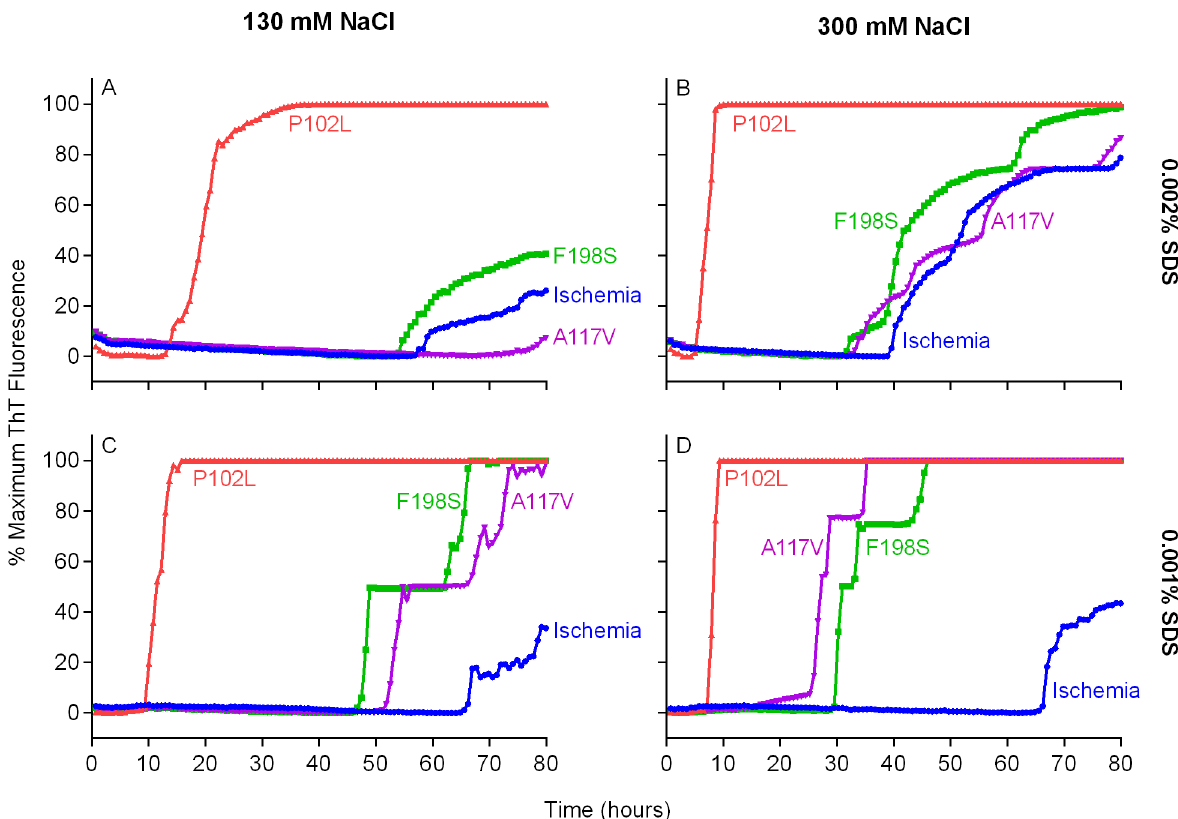
Fig 2. Detection of GSS P102L, F198S and A117V PrP D types by RT-QuIC using BV rPrP Sen , 300mM NaCl and 0.001% SDS. Quadruplicate RT-QuIC reactions were seeded with 10 -4 dilutions of human frontal cortex brain tissue from GSS patients with the P102L (red lines), F198S (green lines), or A117V (magenta lines) PRNP mutation. Negative control reaction were seeded with 10 -4 dilutions of frontal cortex brain tissue from a cerebral ischemia patient (blue lines). A final SDS concentration of 0.002% (A and B) or 0.001% (C and D) in combination with 130 mM (A and C) or 300 mM (B and D) NaCl were used with BV rPrP Sen . Similar results were seen in three independent experiments. Traces from representative RT-QuIC experiments are the average of four replicate wells.